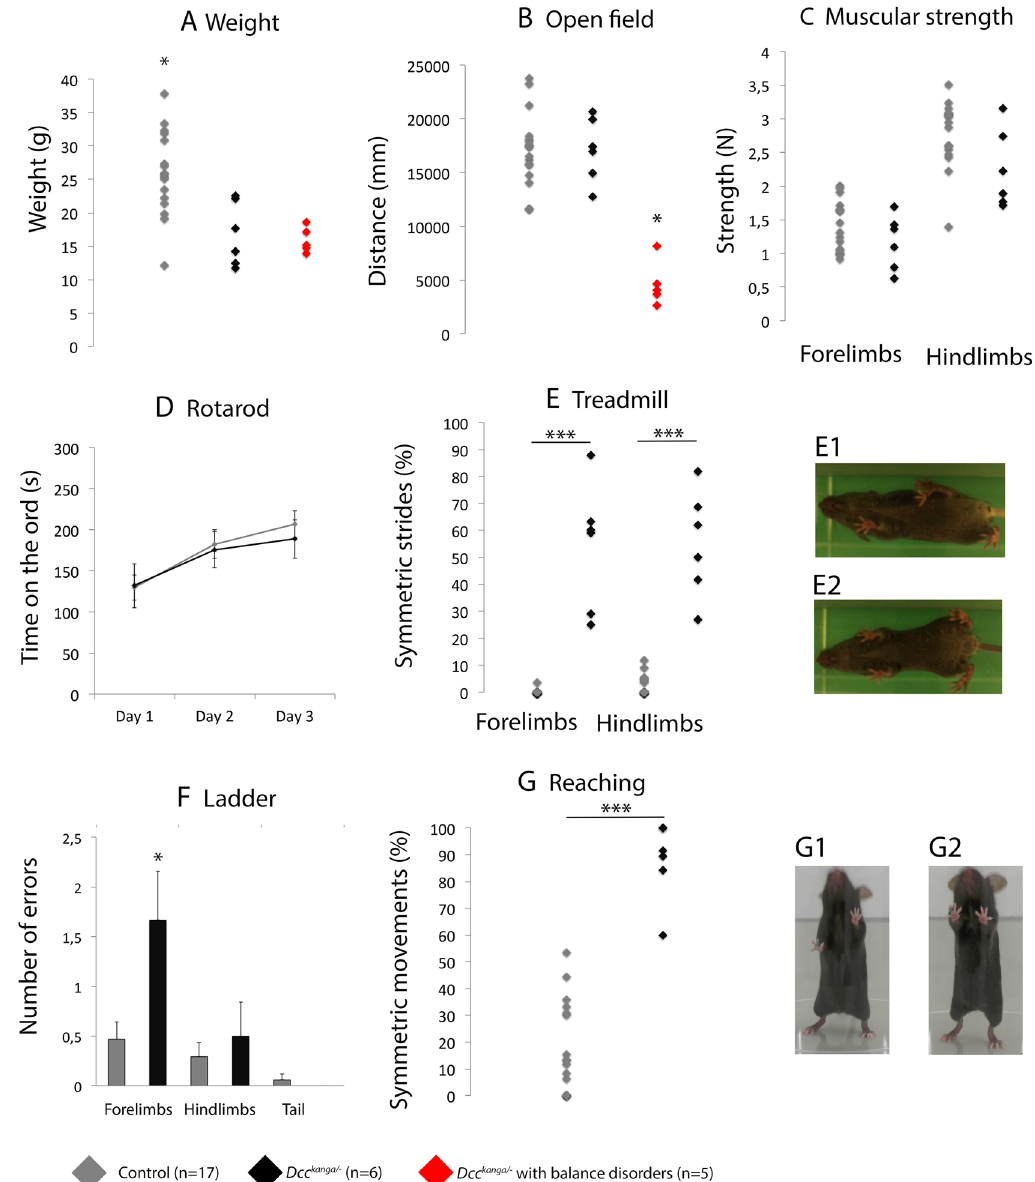
Figure 3. DCC is required for asymmetric movements. We used behavioral tests to investigate the motor phenotype of Dcc kanga / − mutant mice. Dcc kanga / − mice (n = 11; black and red) were compared to Dcc + / + mice or Dcc kanga / + mice (that behave like wildtype mice, n = 17; gray). Five of the 11 Dcc kanga / − mice displayed marked balance disorders (red): they were unable to stand on their limbs and thus moved very little in the open-field test (ANOVA F (2,25) = 33.18, p < 0.001, followed by the Bonferroni post hoc test; B ). Because they were unable to perform most of the motor tests, they were excluded from further analysis. Dcc kanga / − mice were lighter than their littermate controls (ANOVA F (2,20) = 6.27, p = 0.008, followed by the Bonferroni post hoc test; A ) and were accordingly weaker in the muscle strength test (Student’s test, p forelimbs = 0.228; p hindlimbs = 0.042; C ). Dcc kanga / − mice were indistinguishable from controls in the Rotarod test (repeated-measures ANOVA with two factors. F (1,21) = 0.71, p = 0.793, followed by the Bonferroni post hoc test; D ). On the treadmill, Dcc kanga / − mice displayed a striking hopping gait, frequently moving both their forelimbs and their hindlimbs simultaneously (Mann- Whitney test, p forelimbs < 0.0001; p hindlimbs < 0.0001; E , E2). In contrast, control mice made alternating movements (E, E1) of their forelimbs and hindlimbs. In the ladder test, Dcc kanga / − mice made more forelimb errors than the controls (Freeman-Halton extension of Fisher’s exact test, p = 0.038; F ). When placed in a new walled environment, mice have a tendency to establish contacts on the walls with their forelimbs in an asymmetric (G1, control mice) or symmetric (G2, Dcc kanga / − mice) manner. In the reaching test, Dcc kanga / − mice made more symmetric forelimb movements than the controls (Student’s test, p < 0.0001; G